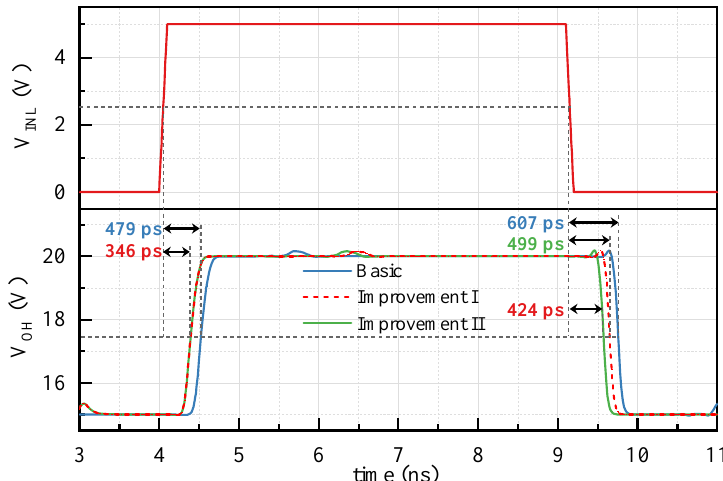
delay is reduced by 22%.